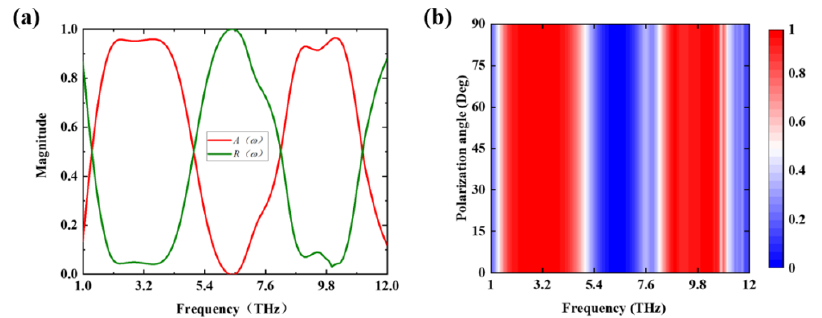
Figure 2. When the conductivity of VO 2 is 2 × 10 5 S/m. ( a ) The reflection and absorption spectra of the dual broadband absorber. ( b ) Color map of absorption spectra with different polarization angles.